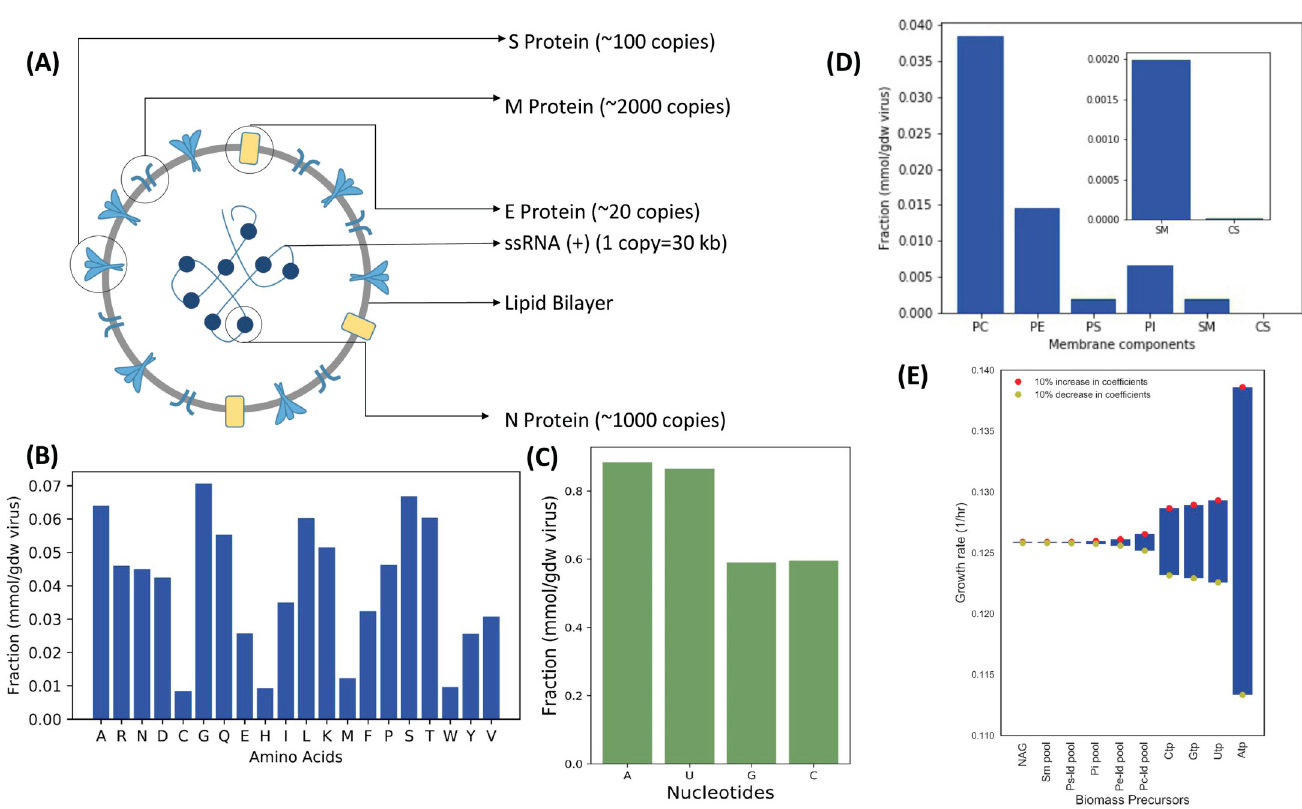
Fig 1. Reconstruction of biomass equation (VBOF) of SARS-CoV-2 virus from its stoichiometric make-up. (A) The stoichiometry of various proteins, nucleic acid and their locations in the SARS-CoV-2 virus. The molar composition of constituent molecules in lipid fraction (B), nucleic acid (C) and proteins (D). PC-Phosphatidylcholine; PE-Phosphatidylethanolamine; PS-Phosphatidylserine; PI-Phosphatidylinositol; SM-Sphingomyelin; CS-Cholesterol. (E) Sensitivity analysis of growth rate of SARS-CoV-2 with respect to coefficient (fractional composition) of biomass precursor. The coefficients are varied by ± 10% and y-axis shows growth rates simulated by Flux Balance Analysis